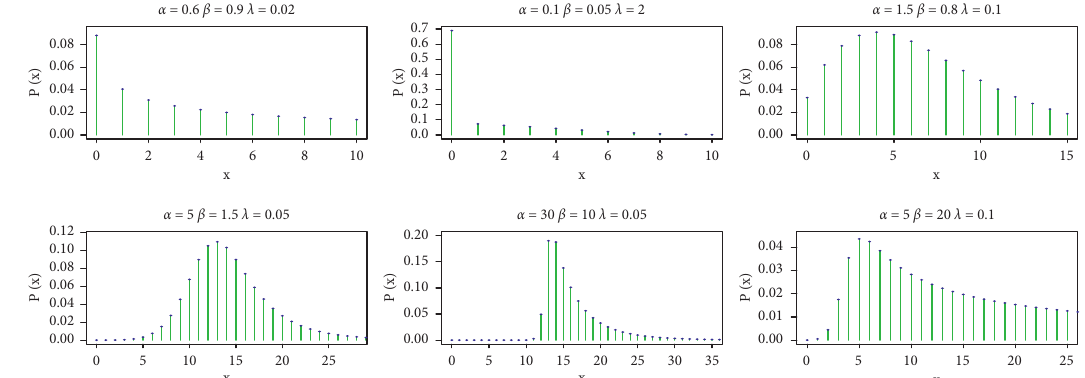
Figure 1: Different shapes’ PMF of DEOWE distribution by using different values of the parameters. These figures show that the PMF can behave in different shapes.